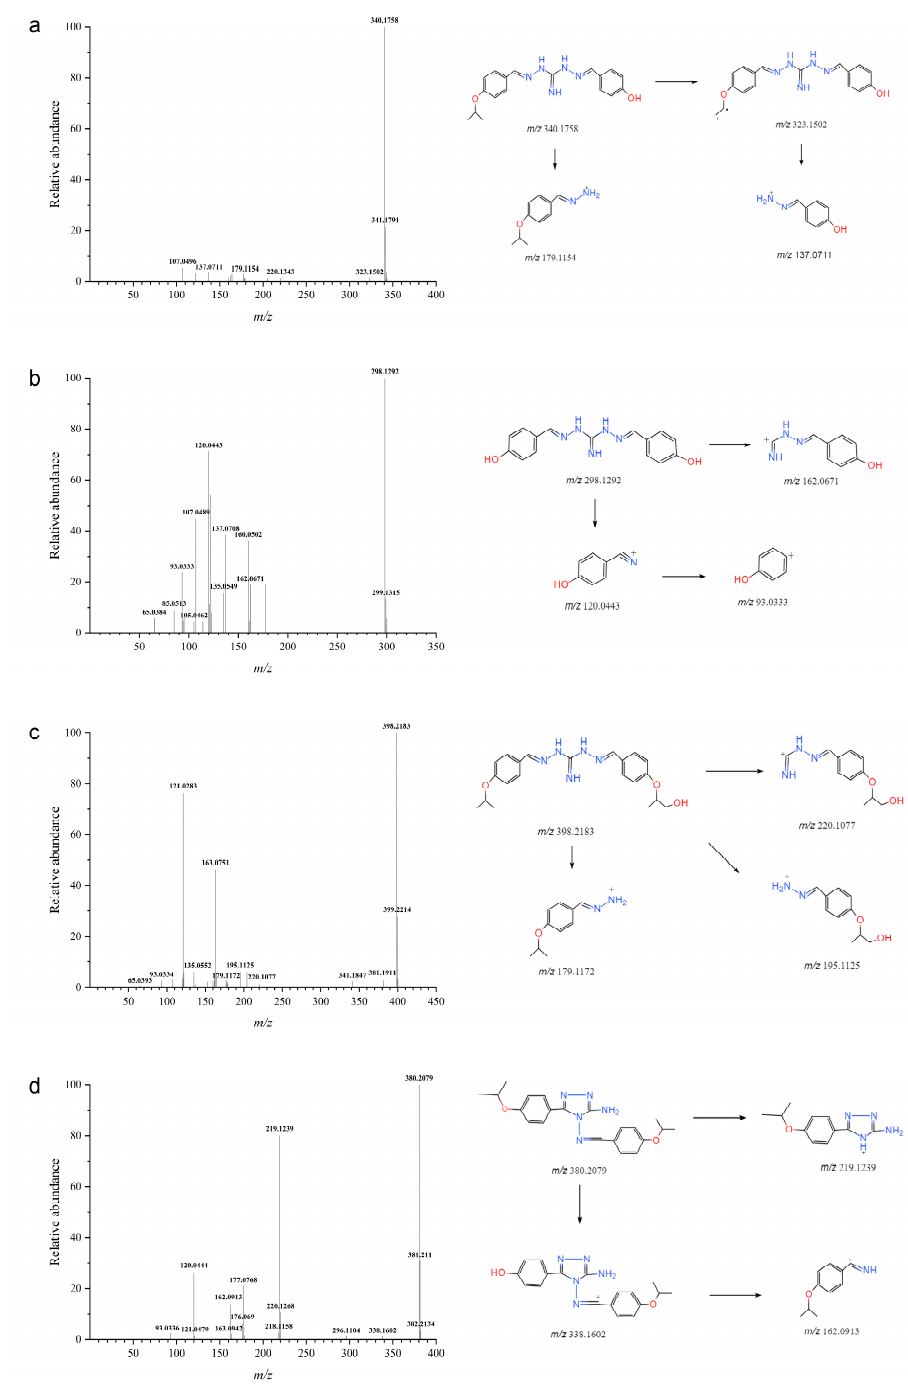
Figure 4. Collision-induced dissociation spectra of M1 ( a ), M2 ( b ), M3 ( c ) and M4 ( d ) and their proposed fragmentations.